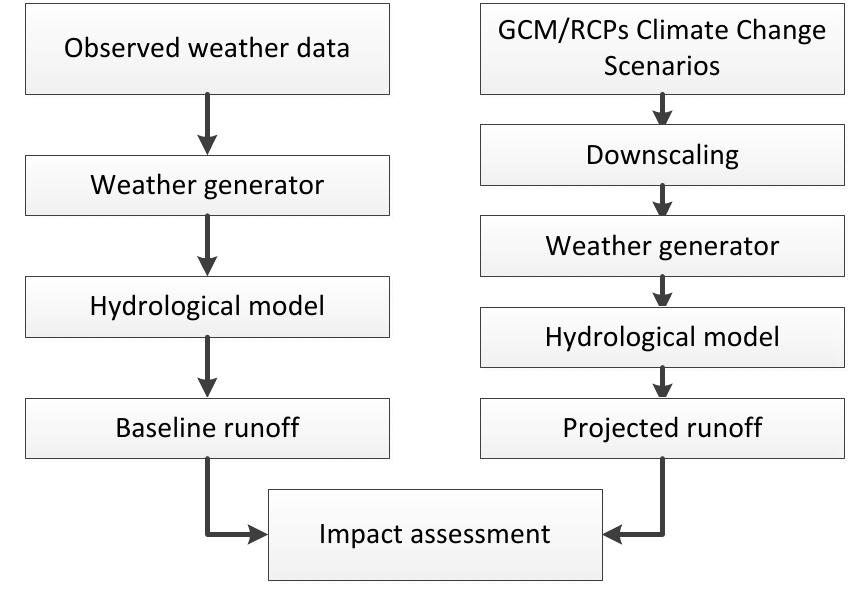
Figure 2. Methodology framework of impact assessment.